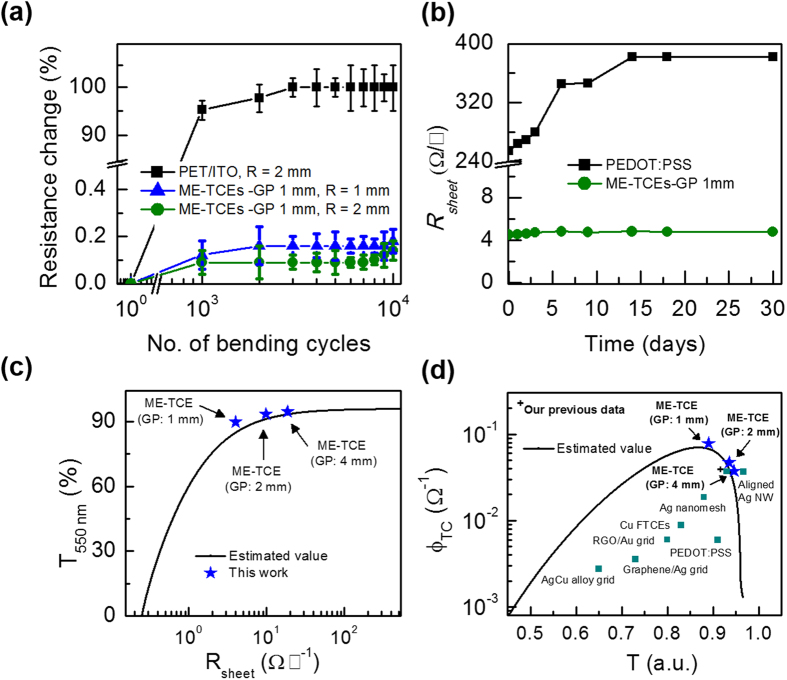
(a) Resistance changes of the TCEs with various quantities of bending cycles and bending radii. (b) Sheet resistance (Rsheet) values of TCEs films stored in ambient air at 25 °C vs. storage time. (c) Optical transmittance (T550 nm) values plotted as a function of sheet resistance for ME-TCEs with different GP sizes. (d) ΦTC values as a function of transmittance. For comparison, the ΦTC value of Ag mesh45, aligned Ag NW15, Ag nanomesh26, Cu flexible TCEs (FTCEs)46, reduced graphene oxide (RGO)/Au grids4, graphene/Ag grids47, AgCu alloy mesh48, and modified PEDOT:PSS6 are also shown.